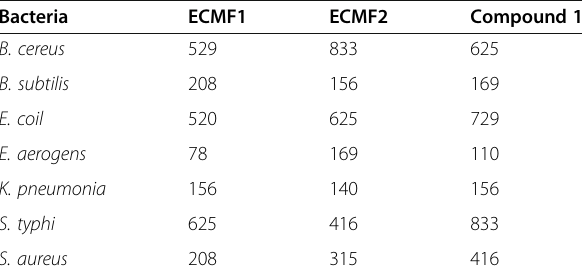
Table 5 MIC of methanol fractions and compound 1 of E. cotinifolia against human pathogenic bacteria (in μ g/ml) Bacteria